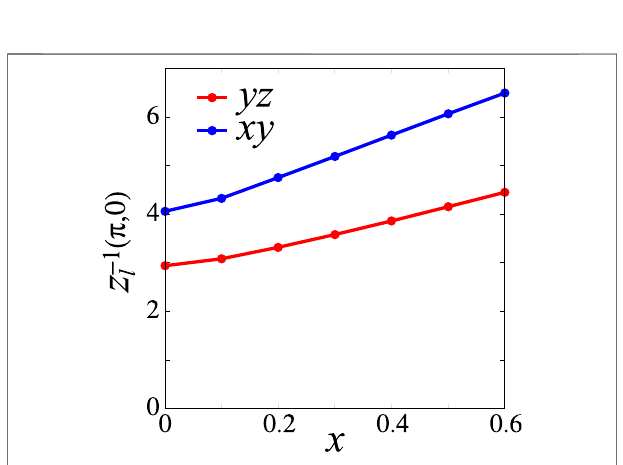
FIGURE 5 | x dependences of the mass enhancement factor z − 1 l ( π , 0 ) for orbitals l = 3 and 4.